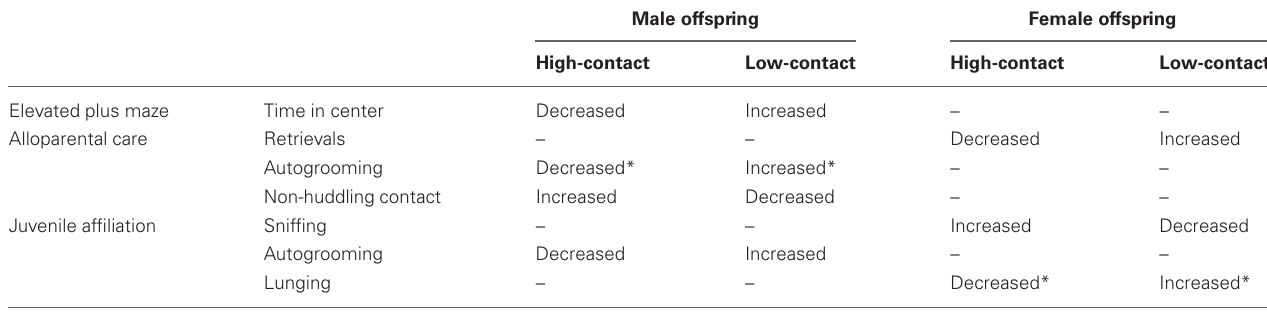
Table 6 | Summary of social and anxiety-like behavioral differences between high- and low-contact offspring by